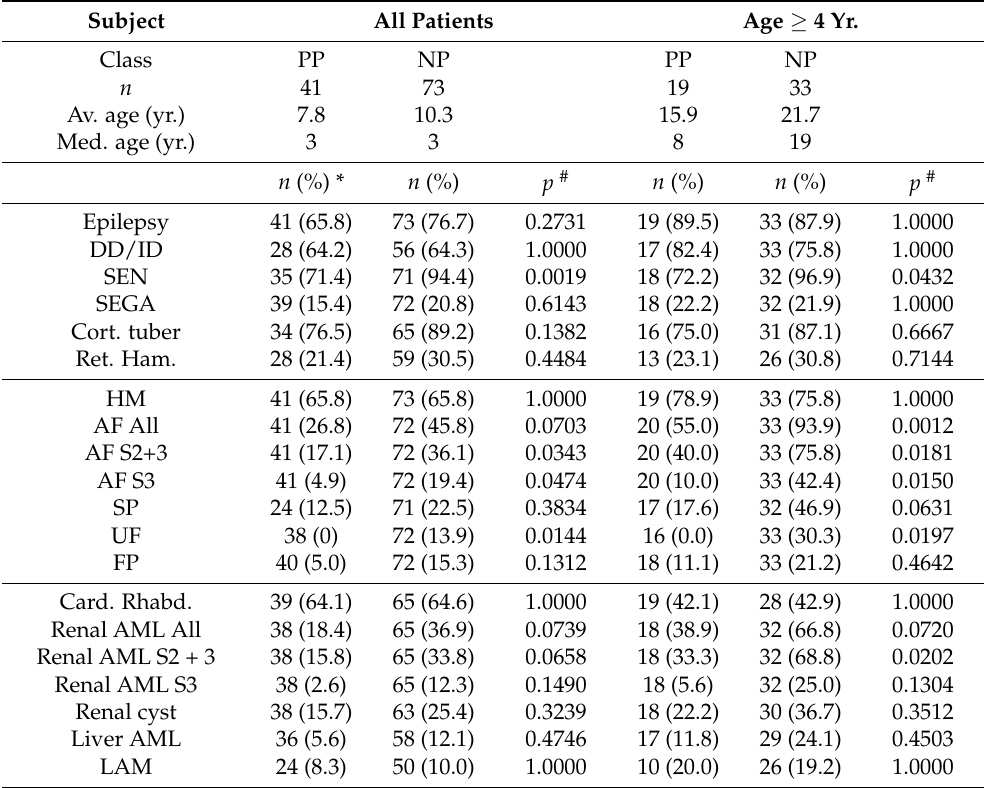
Table 8. Difference of each symptom and lesion between TSC2 mutations predicted to produce a protein (PP), and mutations predicted to produce truncated protein or no protein